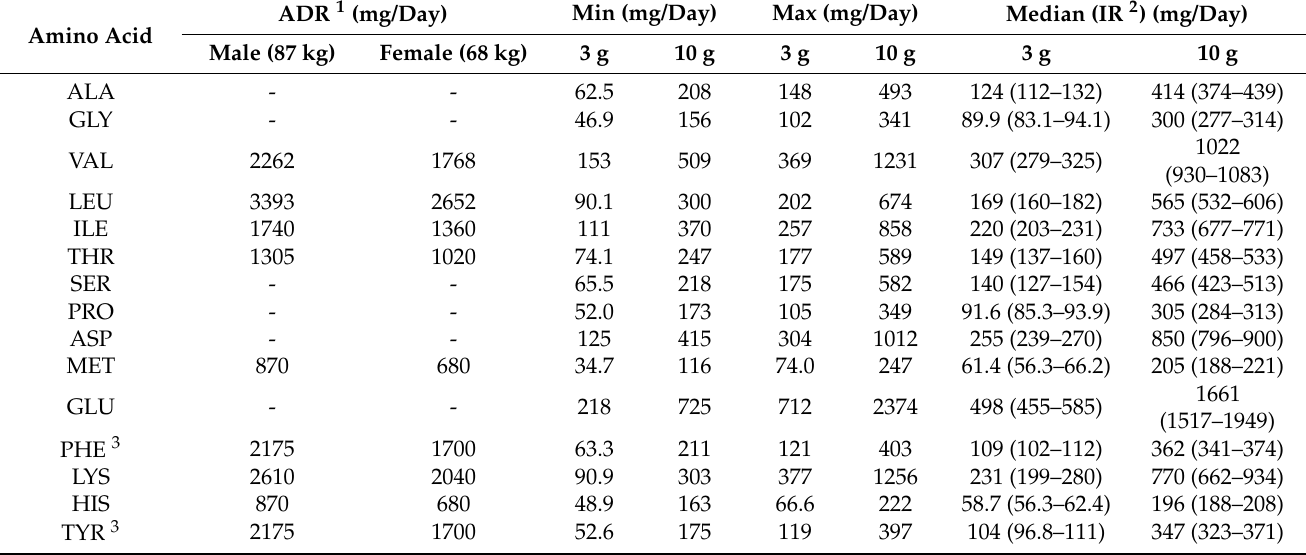
Table 6. Total amino acid content (mg/day) in Spirulina supplements, presented for minimal (3 g) and maximal (10 g) recommended daily